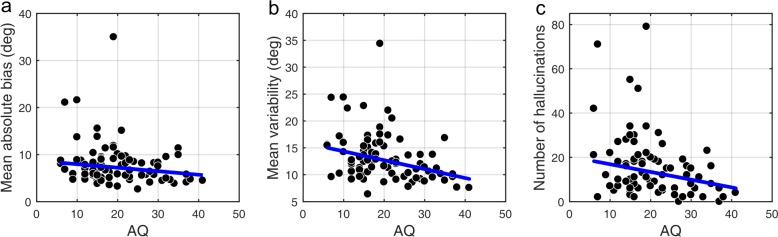
Correlations between AQ scores and task performance on low contrast trials (a, b) and when no stimulus is presented (c).(a) Mean absolute bias (r = −0.175, p=0.053), (b) mean standard deviation (i.e. variability) of estimations (r = −0.327, p<0.001), and (c) the total number of hallucinations (r = −0.238, p=0.010). The blue lines are robust regression slopes.10.7554/eLife.34115.007Figure 4—source data 1.This zip archive contains .csv files with all of the data that was used to produce plots in Figure 4.EstimationBias.csv contains estimation biases at each of the nine presented angles. EstimationVariability.csv contains standard deviation of estimations at each of the nine presented angles. NostimDetected.csv contains the number of hallucinations at different directions. Traits.csv contains AQ scores of each individual (column 3) as well as all other traits. SourceData_Readme.txt contains more detailed description of each data file. The plots were produced with MATLAB script analyze_data.m which is available in the provided Source code 1. SourceCode_Readme.txt contains more detailed description of the source code.